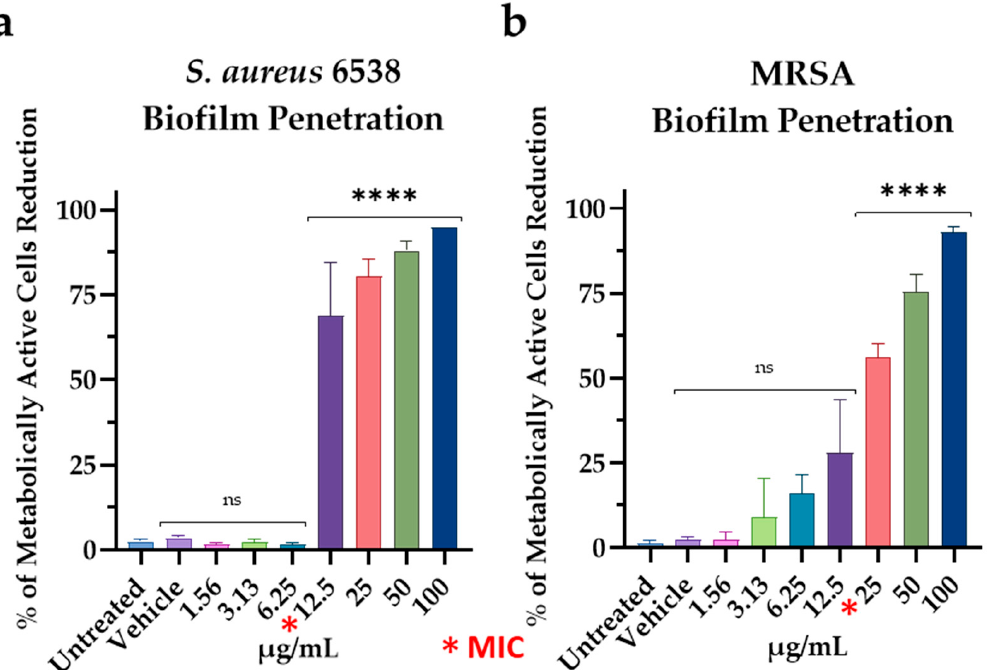
Figure 6. The ability to kill S. aureus 6538 ( a ) and MRSA ( b ) bacteria inside the biofilm was evaluated by the biofilm penetration assay. Results are presented as the percentage reduction of metabolically active cells. Statistical analyses were determined by ANOVA with Dunnett’s test for multiple comparisons. Significances are referred to the untreated biofilms. **** p < 0.0001, ns (not statistically